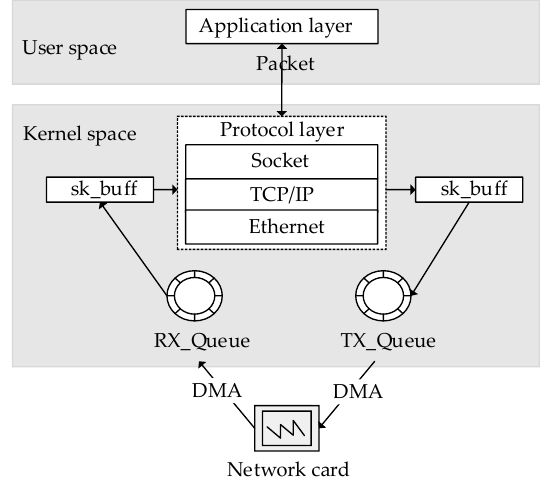
Figure 2. Packet path.